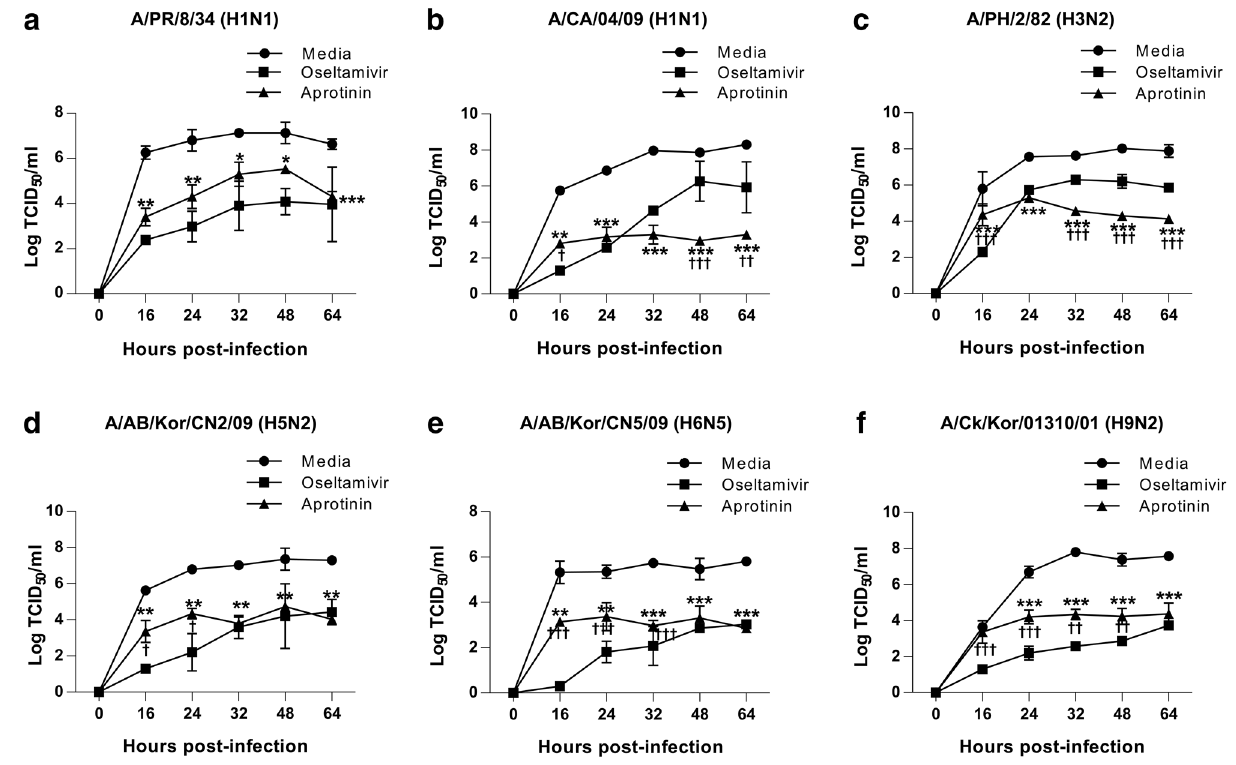
Figure 3. Aprotinin inhibited the replication of various strains of human influenza A virus in Madin–Darby canine kidney (MDCK cells. The replication kinetics of ( a ) A/PR/8/34 (H1N1), ( b ) A/CA/04/09 (H1N1), ( c ) A/ PH/2/82 (H3N2), ( d ) A/AB/Kor/CN2/09 (H5N2), ( e ) A/AB/Kor/CN5/09 (H6N5), and ( f ) A/Ck/Kor/01310/01 (H9N2) virus were investigated in MDCK cells after treatment with aprotinin and oseltamivir. MDCK cells were infected with influenza virus at an MOI of 0.001 (H6N5) or 0.01 (all viruses except H6N5) for 1 h and then treated with aprotinin (60 nM) or oseltamivir (100 μM). Supernatants were collected pre-infection (0) and at 16, 24, 32, 48, and 64 h post-infection, and viral titers in the supernatants were determined by the TCID 50 assay. * P < 0.05, ** P < 0.01, and *** P < 0.0001, statistically significant difference between the virus-only (media) group and the aprotinin treatment group. † P < 0.05, †† P < 0.01, and ††† P < 0.0001, statistically significant